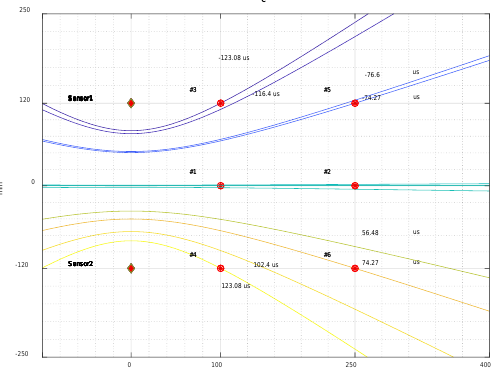
Figure 15. Graph of (4) drawn with a base velocity of 1.3 mm/ µ s and two DToAs for each point (#1, #2, #3, #4, #5, #6). The first DToA is theoretically estimated (curve intersect in the red point) and the